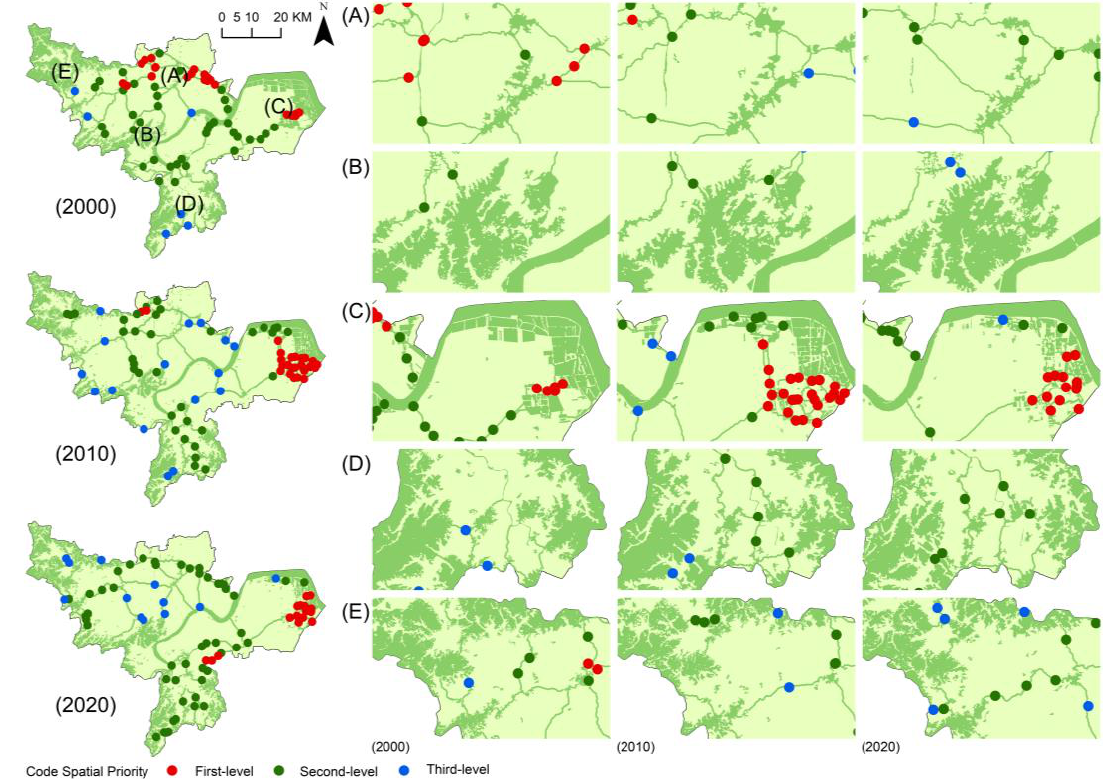
Figure 7. GI codes ’ spatial priority distribution at all levels in 2000, 2010, and 2020: ( A ) Banshan National Forest Park, ( B ) West Lake Scenic Area, ( C ) Qiantang River Wetland, ( D ) Shiniu Mountain– Qinghua Mountain Scenic Area, and ( E ) Jingshan Scenic Area.